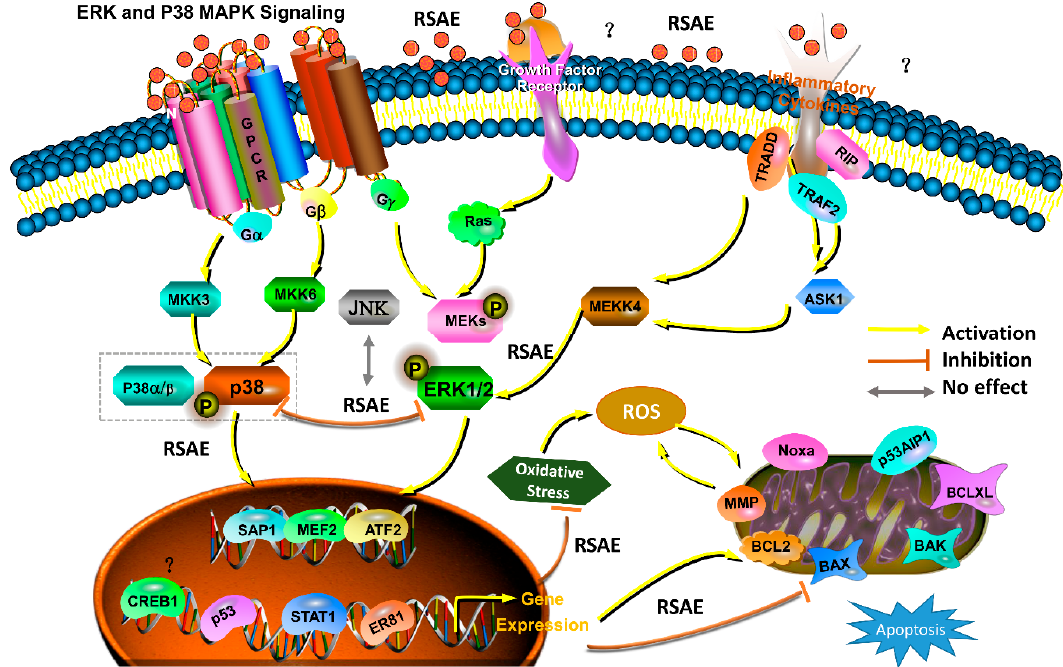
Figure 9. Graphic summary of the neuroprotective effects that Radix Scrophulariae aqueous extract exerts on cerebral ischemia and reperfusion injury by inhibiting apoptosis via the ERK1/2 and p-38 MAPK pathways.